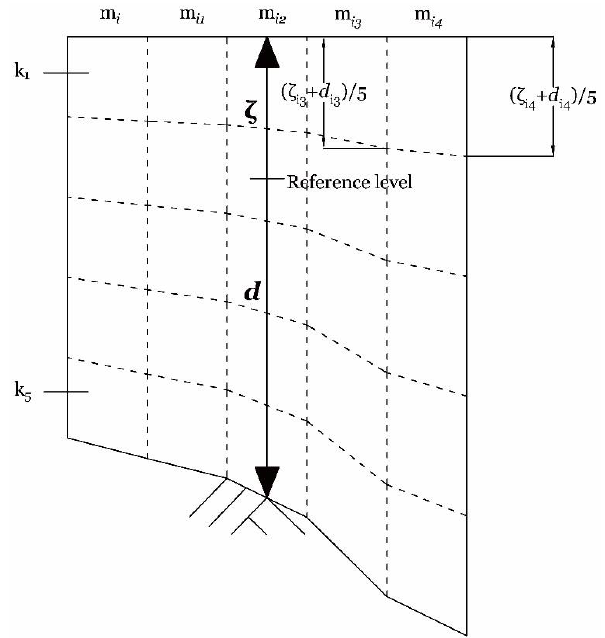
Figure A1. Vertical cross-section layout for volume exchange calculation.